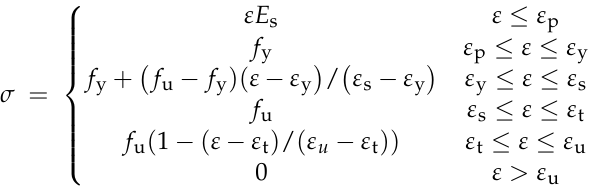
Table 7. Parameters of CDP model